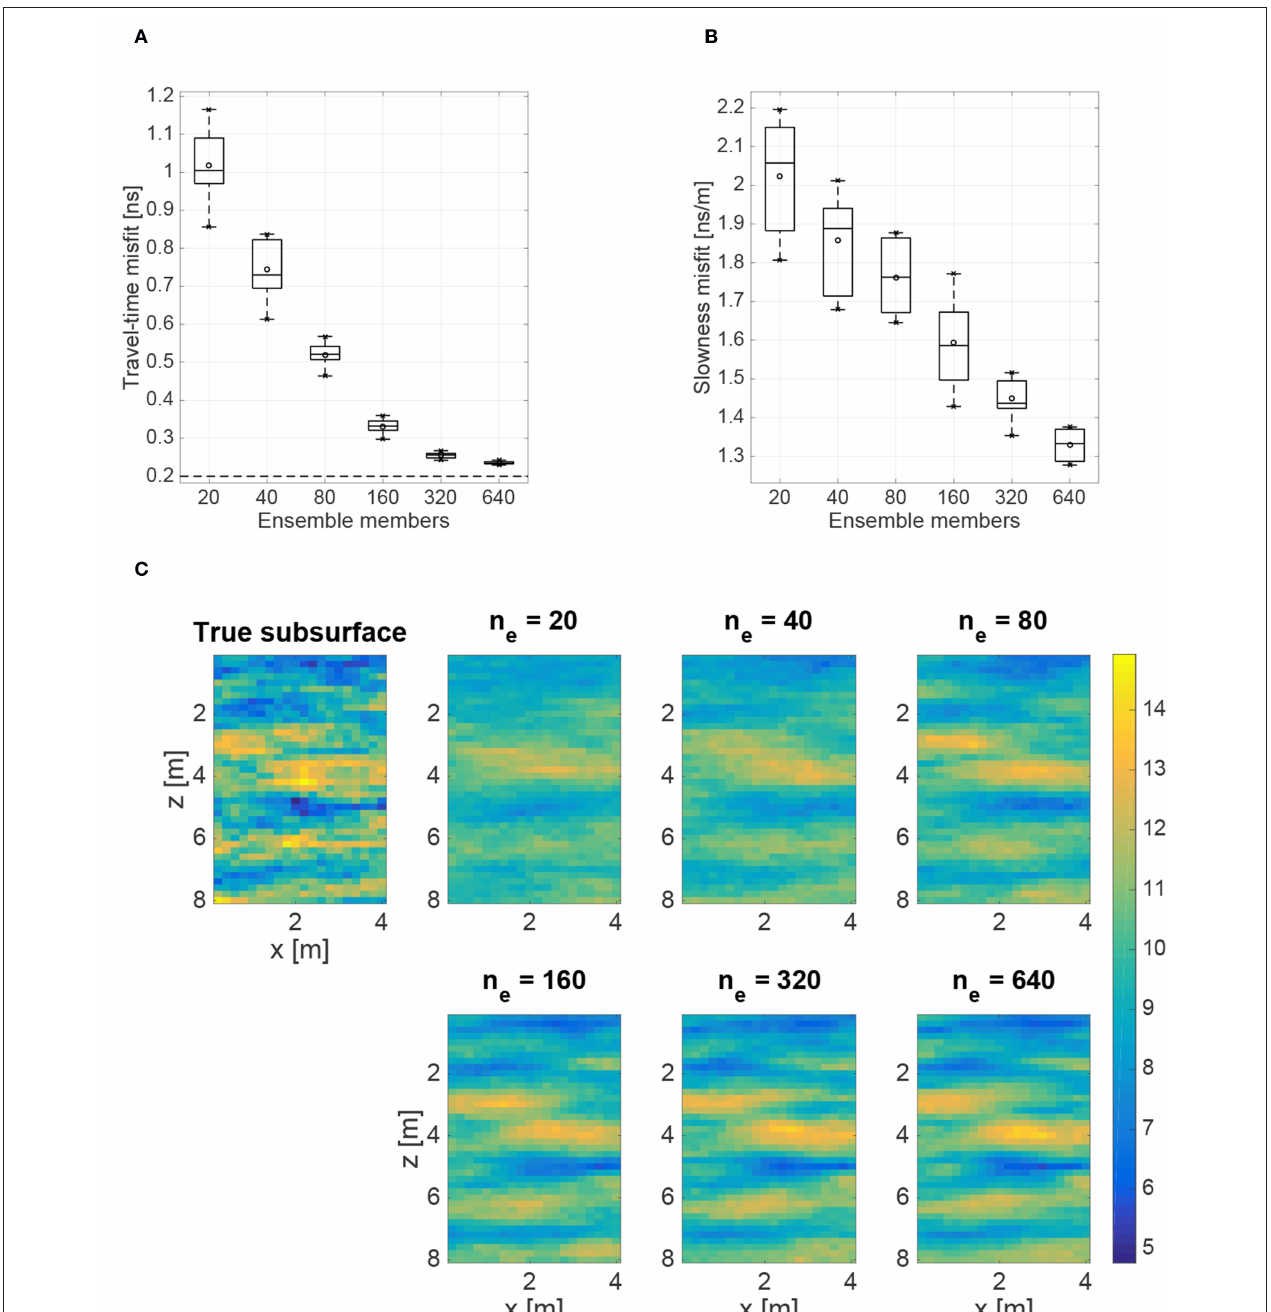
FIGURE 2 | Results of 10 standard ES-MDA runs for the case of no model error. Shown as a function of the number of ensemble members, n e , are (A) box plots of the average RMS travel-time misfit [ns]; (B) box plots of the average RMS slowness misfit [ns/m]; and (C) the mean posterior slowness fields [ns/m]. Added to the box plots are the mean (circles), and minimum and maximum values (crosses). The dashed horizontal line in (A) represents the expected value of the travel-time misfit assuming that the residuals follow the prescribed Gaussian distribution for the data